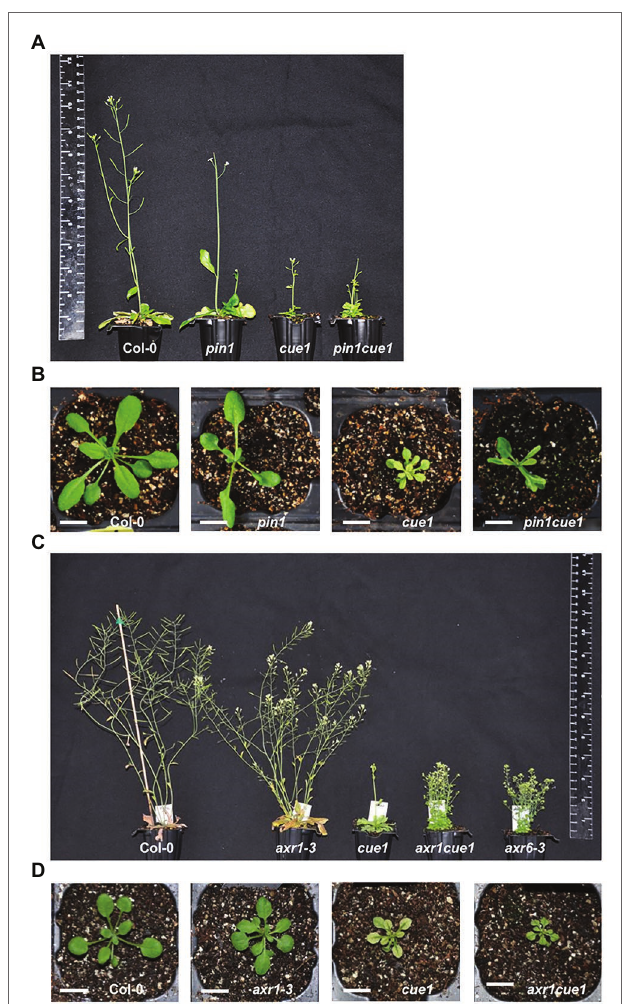
FIGURE 4 | The cue1 mutation alters auxin transport and increases auxin response impairment. Phenotype of 30-day-old plant rosettes (A) and 21-day-old plant rosettes (B) in wild type (Col-0), pin1 mutant altered in auxin transport, NO overproducer cue1 mutant, and pin1cue1 double mutant. Phenotype of 50-day-old plant rosettes (C) and 21-day-old plant rosettes (D) in wild type (Col-0), axr6-3 , axr1-3 , cue1 , and double axr1-3cue1 . Plants were grown on MS for 14 days at 20 ° C, then transferred to soil and grown in the